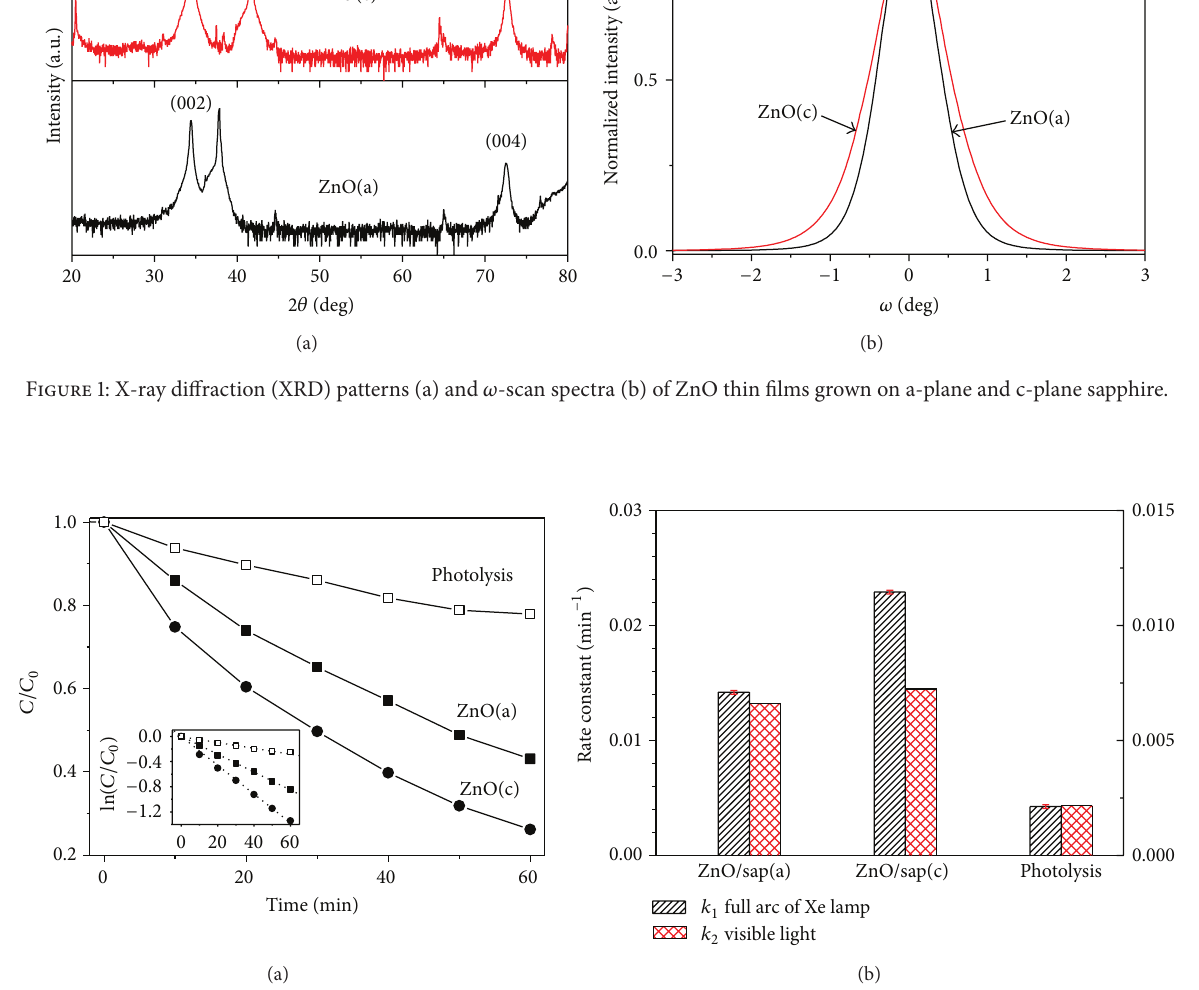
Figure 2: (a) Variation in RhB concentration over ZnO thin films grown on a-plane and c-plane sapphire; the inset of a is the plot of first order kinetics. (b) Rate constant in the degradation of RhB over ZnO thin films grown on a-plane and c-plane sapphire under full arc and visible light irradiation of Xe